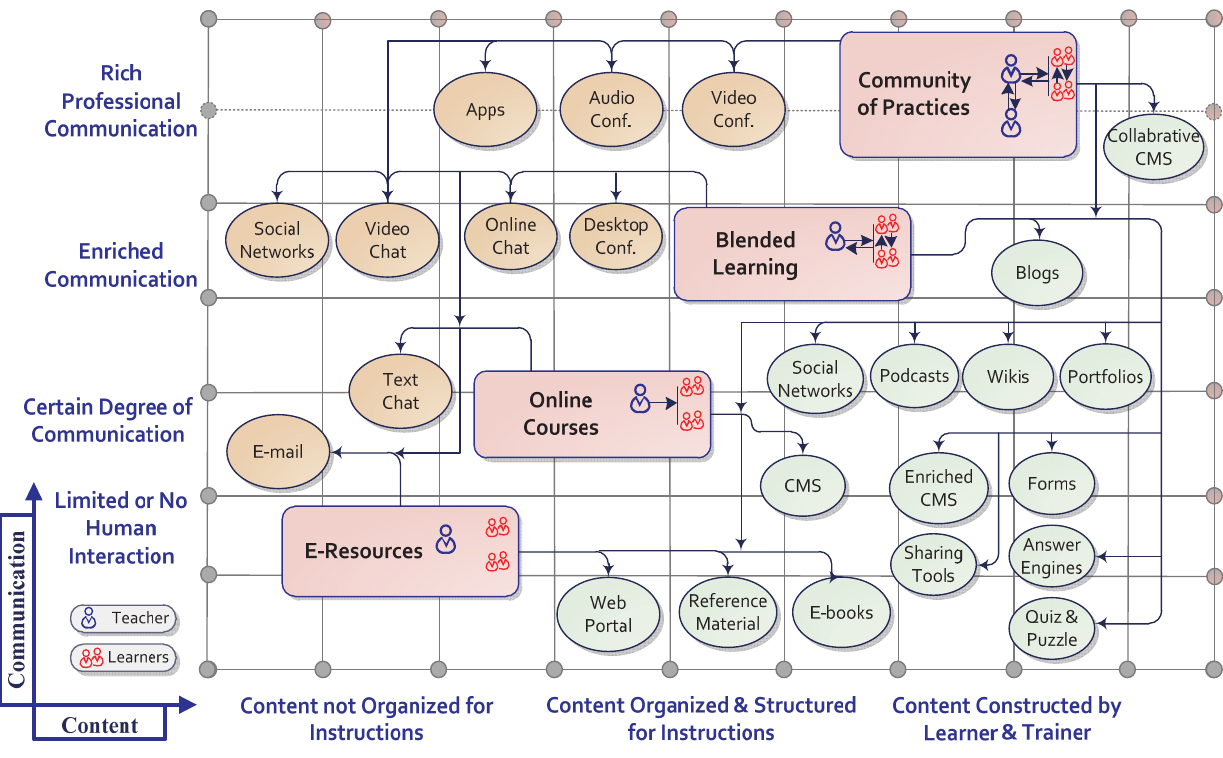
Figure 4 : Different forms of